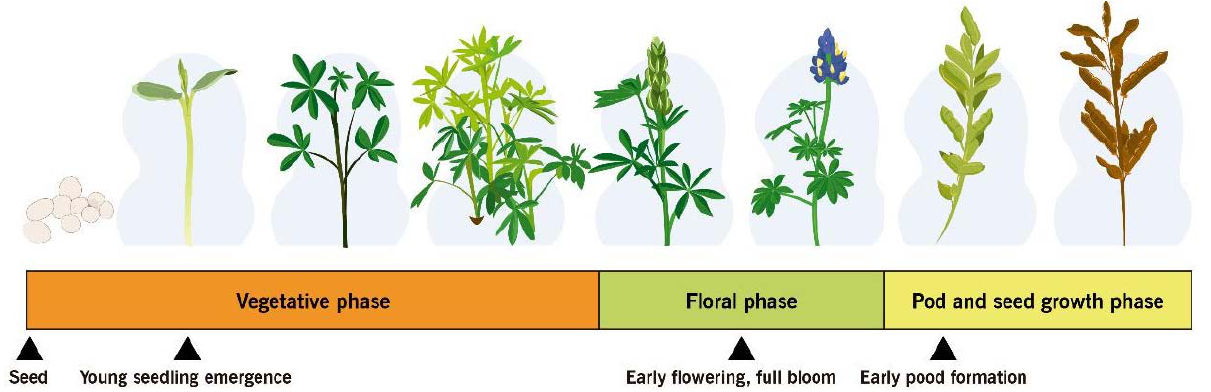
Figure 8. Anthracnose susceptible phenological stages of